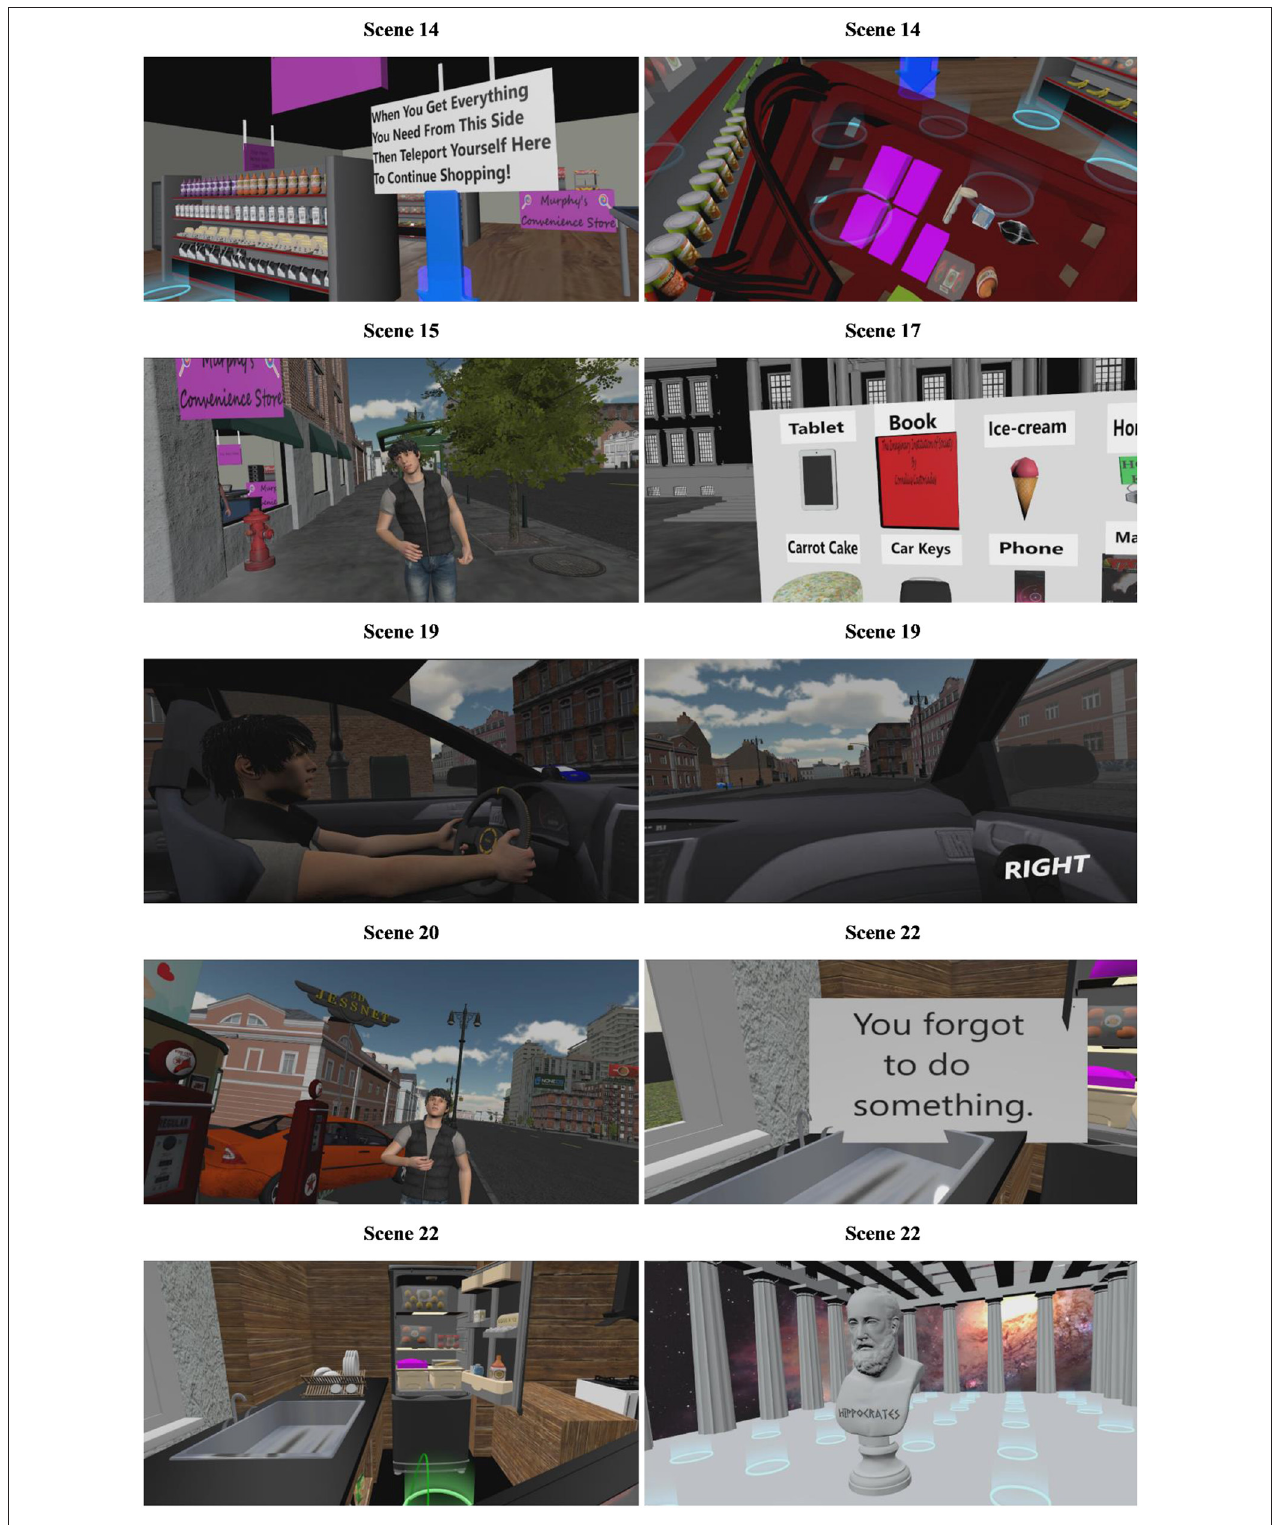
FIGURE 6 | VR-EAL storyline: scenes